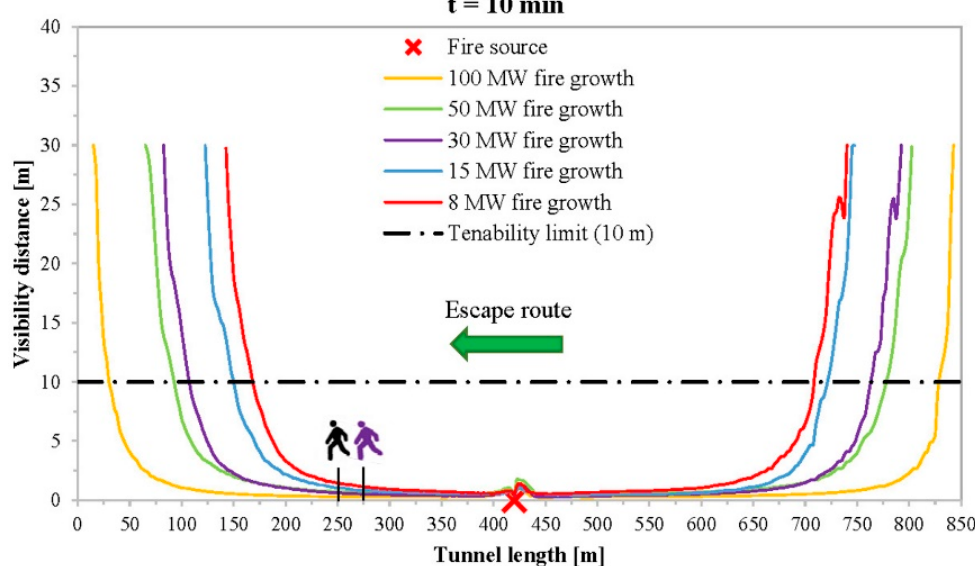
Figure 10. Profiles of longitudinal visibility distance at a height of 2 m along the escape route on the road carriageway after 10 min from the fire’s start when the burning vehicle is at 420 m from portal A.